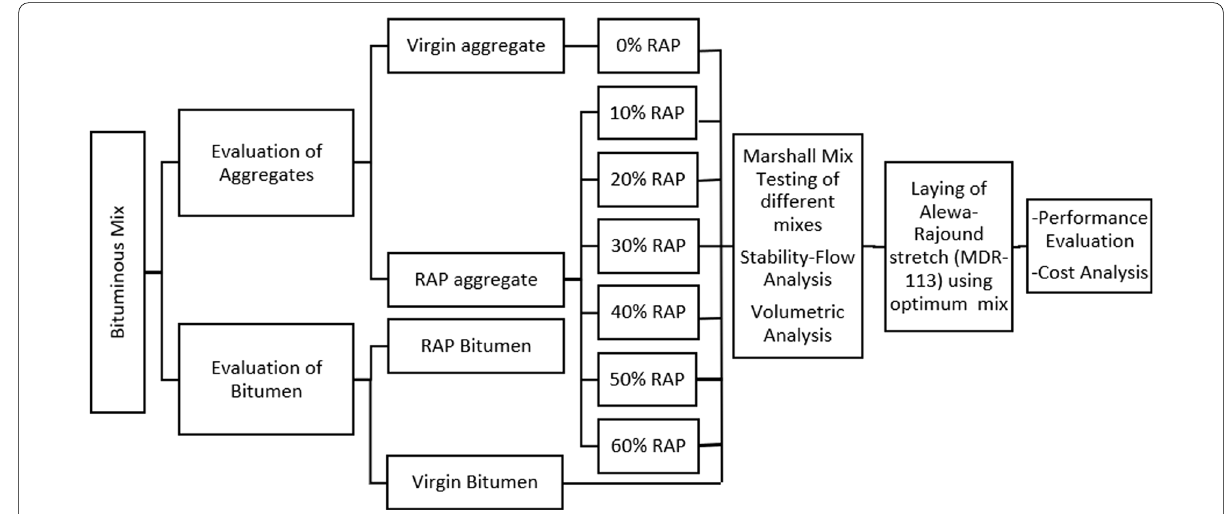
Fig. 2 Flowchart depicting methodology